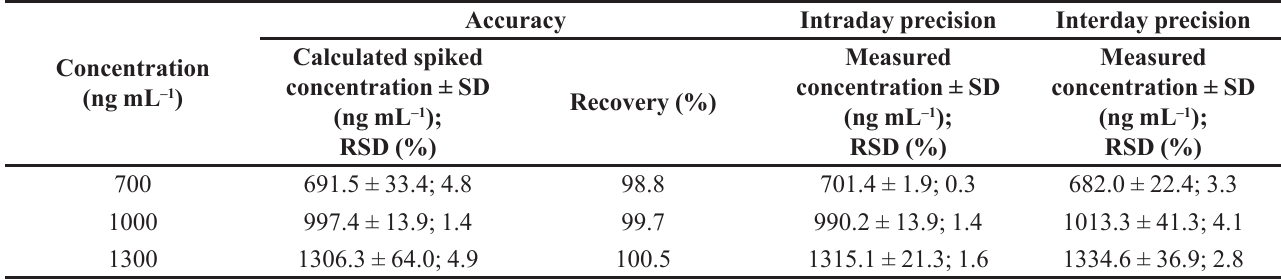
TABLE II - Accuracy ( n = 3) and precision ( n = 9) of the method